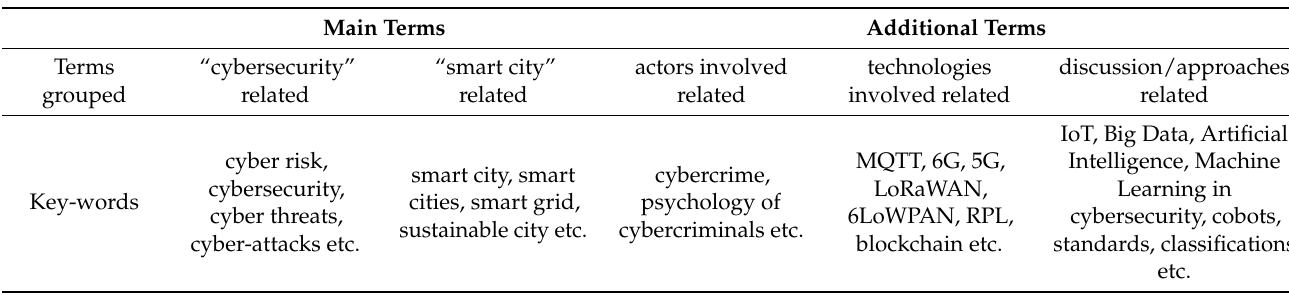
Table 1. Key-words used for searching.